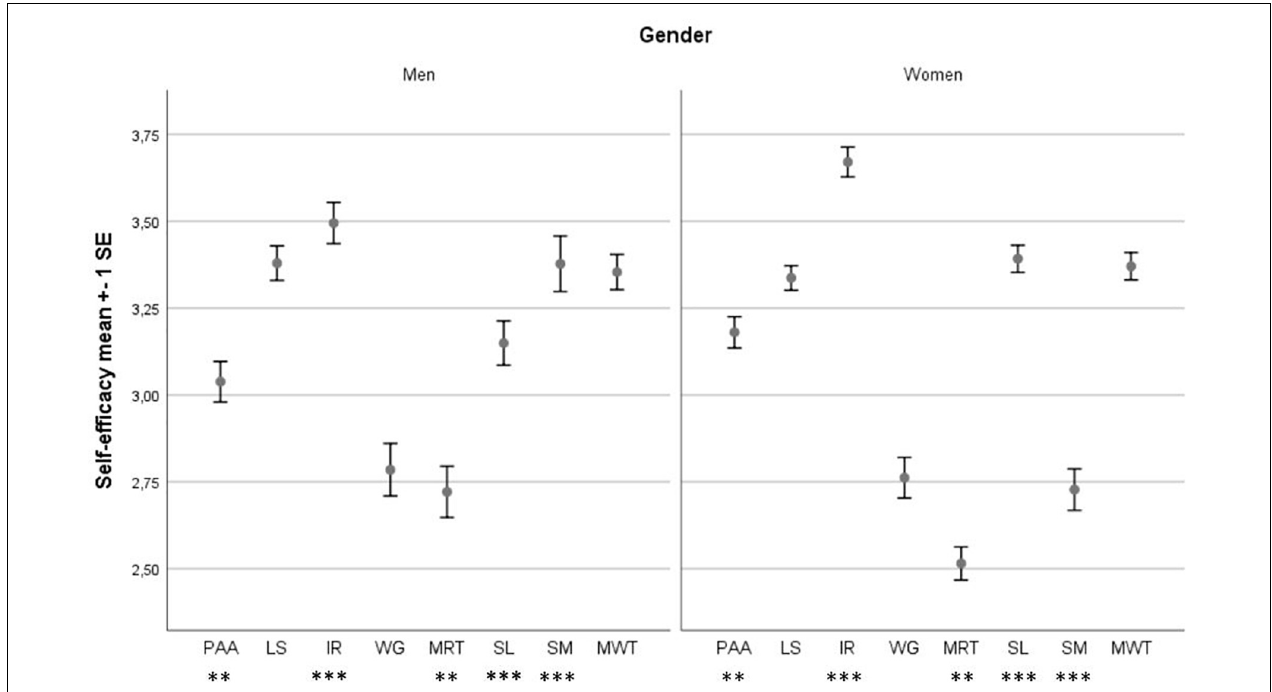
FIGURE 1 | Mean levels of the Academic Self-efficacy factors for men and women and t -test results. ∗∗ p < 0.01; ∗∗∗ p < 0.001; PAA, “Planning Academic Activities”; LS, “Learning Strategies”; IR, “Information Retrieval”; WG, “Working in Groups”; MRT, “Management of Relationships with Teachers”; SL, “Skills for Lessons”; SM, “Stress Management”; MWT, “Management of Thesis Work.”